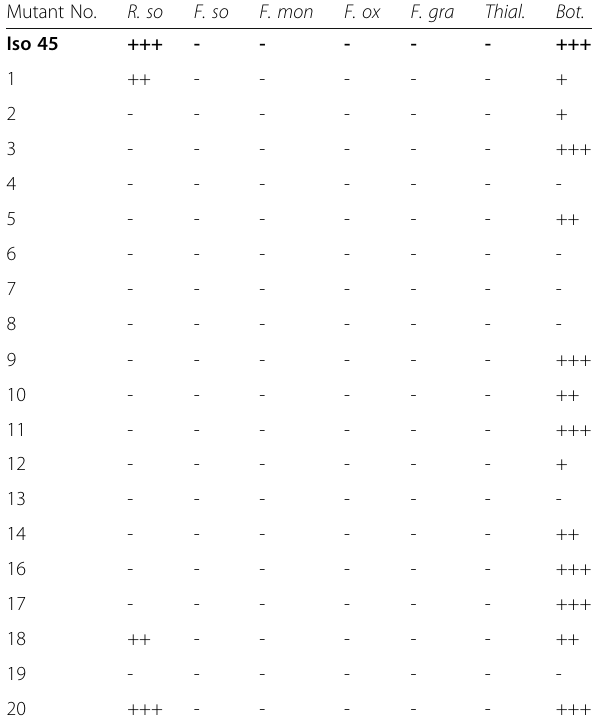
Table 5 Quantitative reaction of mutants of bacterial isolate no. 45 ( Pseudomonas sp.) tested for their antagonism against